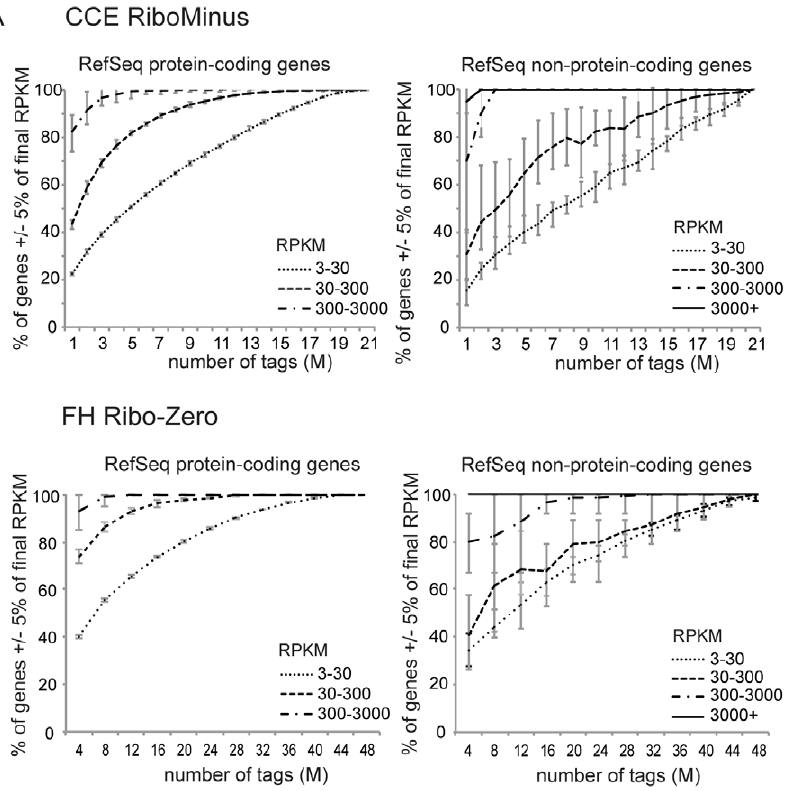
Figure 3. Ribo-depleted RNA-Seq reliably detects expression of known protein-coding and non-coding genes. ( A ) Saturation curves showing the percentage of RefSeq protein-coding genes (left) or RefSeq ncRNAs (right) with an RPKM + / 2 5% of the final RPKM for the combined CCE RiboMinus dataset (calculated at the maximum tag number) at different sequencing depths crated by randomly picking the indicated number of tags (M: million). The lines show three groups of genes with similar RPKM expression levels. Error bars indicate the minimum and maximum of ten random tag sets. If the curves reach a plateau before the final number of tags, this indicates that this gene group was sequenced exhaustively, as obtaining more tags does not change their RPKM. The large error bars originate from small gene numbers in the categories, where a small number of changed genes results in a large relative change. ( B ) As in A for the FH Ribo-Zero dataset.